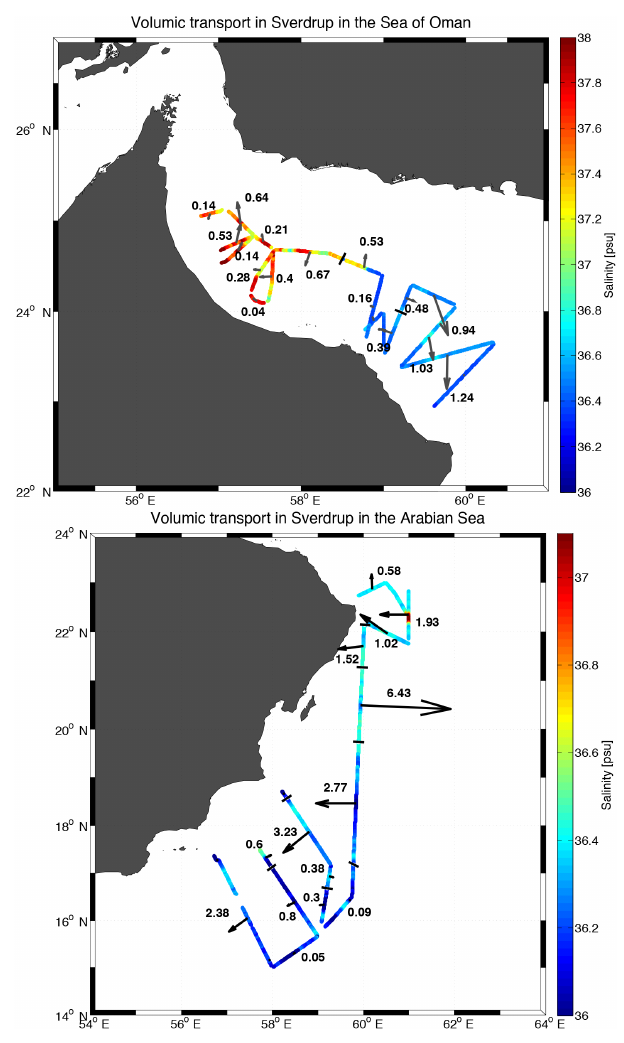
Figure 11. Eulerian volumic transport across the SeaSoar/VM- ADCP sections in the Sea of Oman (top) and in the Arabian Sea (bottom). Arrows indicate the direction, the values are in Sverdrup, and in color is indicated the maximum of the salt in the PGW